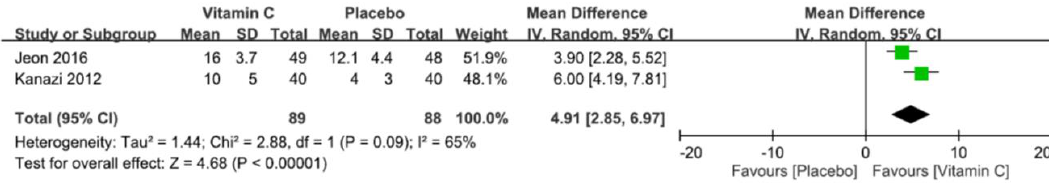
Figure 14. Forest plot for the comparison of postoperative circulating vitamin C concentration between vitamin and placebo groups. CI, confidence interval; IV, inverse variance; WMD, weighted mean difference.